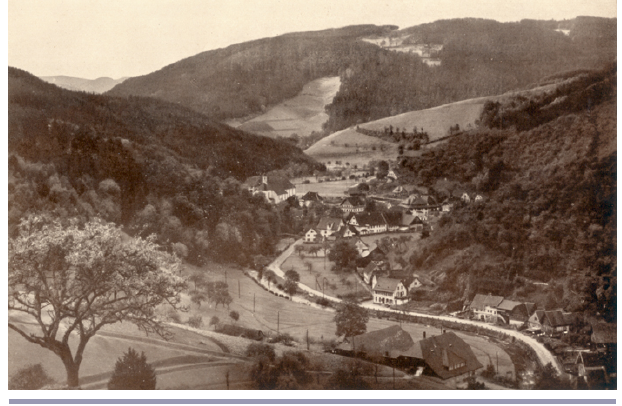
Fig. 3 . View of Schapbach in the first half of the